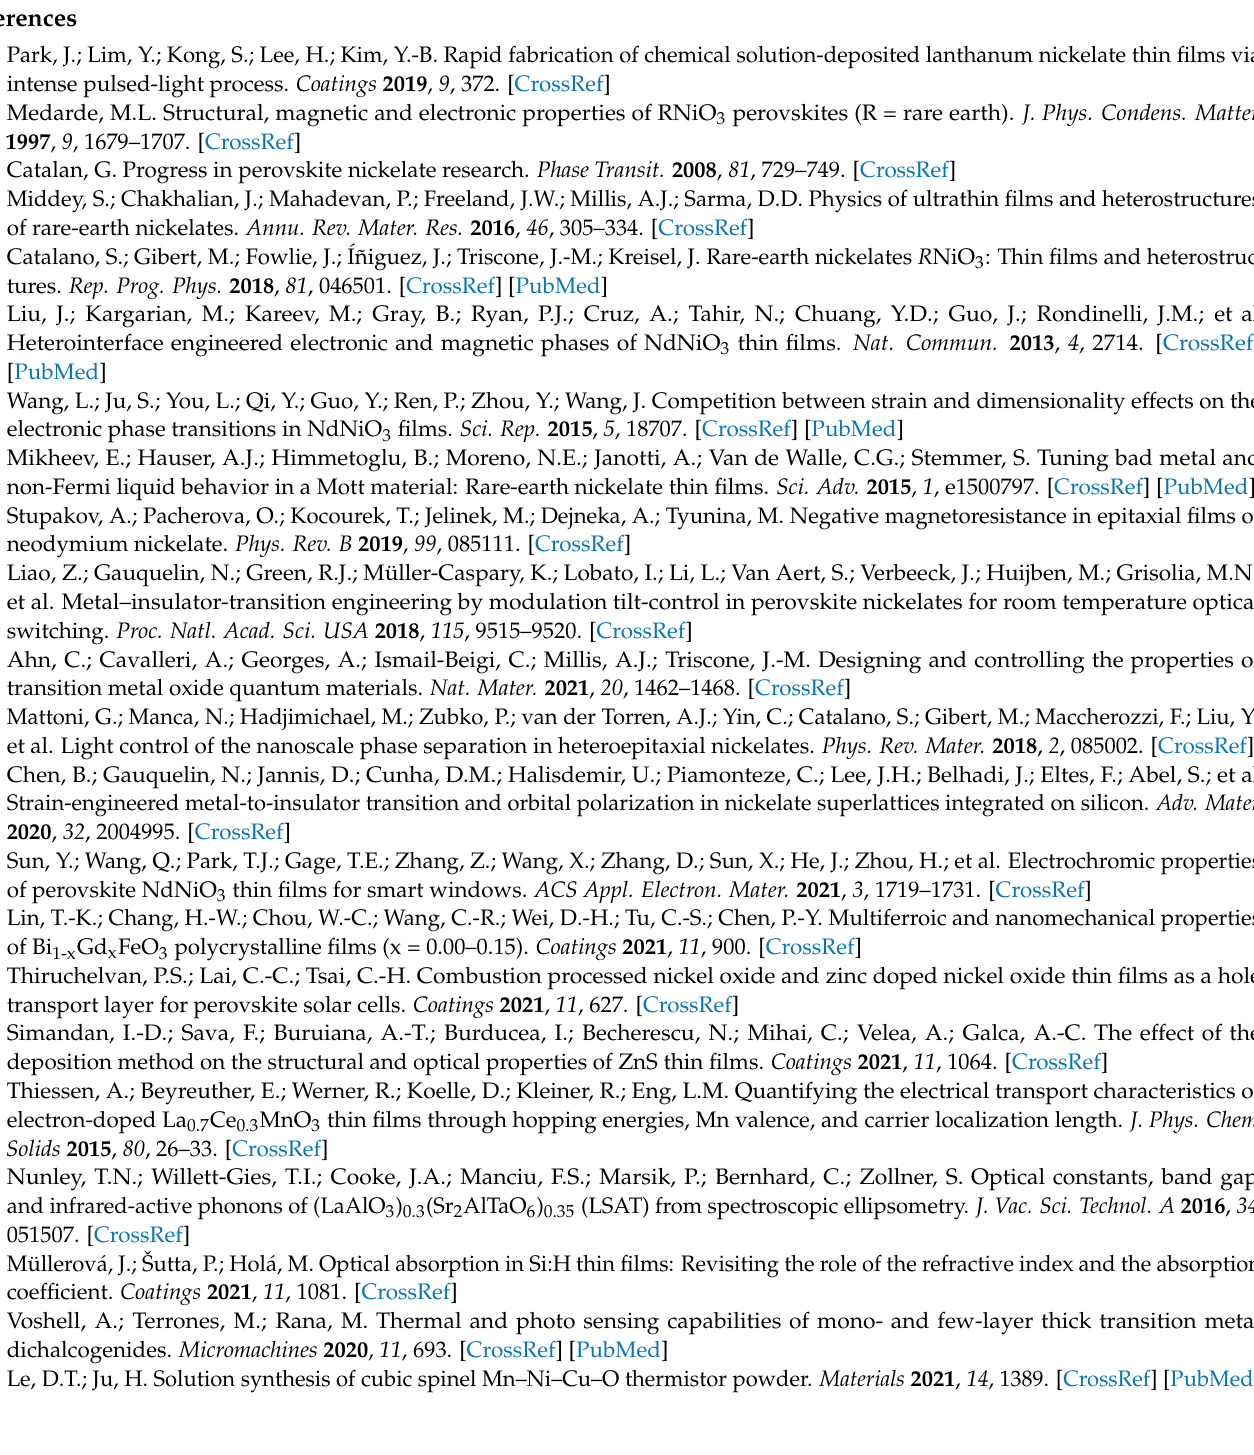
Table values of the heat capacity and the density (0.57 and 0.733 J/g · K as well as 6.74 and 2.65 g/cm 3 for LSAT and quartz, respectively) are taken to estimate a heating of the isolated substrates of 3.2 × 10 mm size in the main